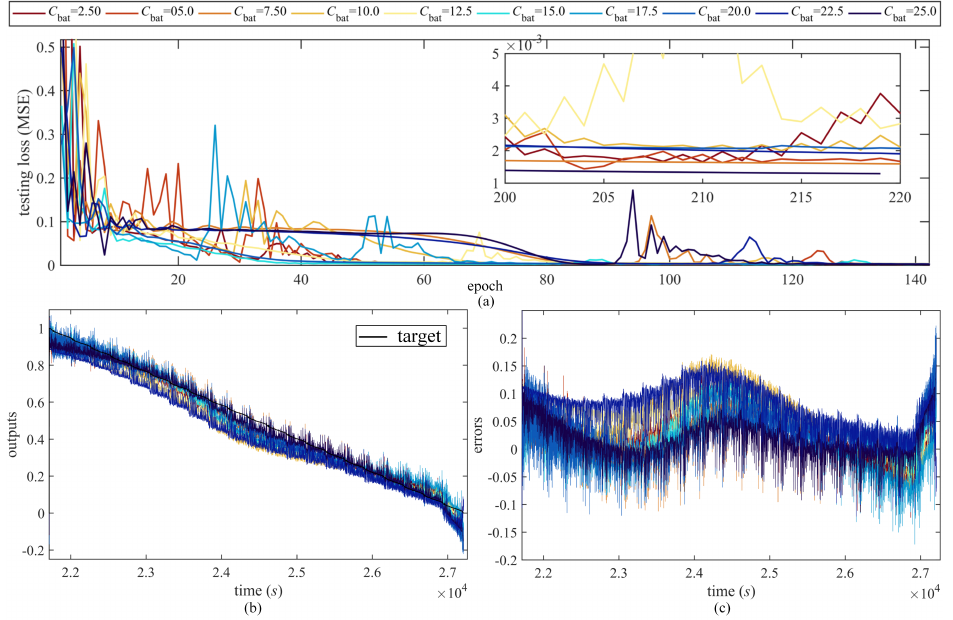
Figure 13. Sensitivity of the capacitance C bat in battery FOM for fractional-order PDE constraint, C bat = 2.5:2.5:25, ( a ) testing loss, ( b ) testing outputs, and ( c ) testing errors.